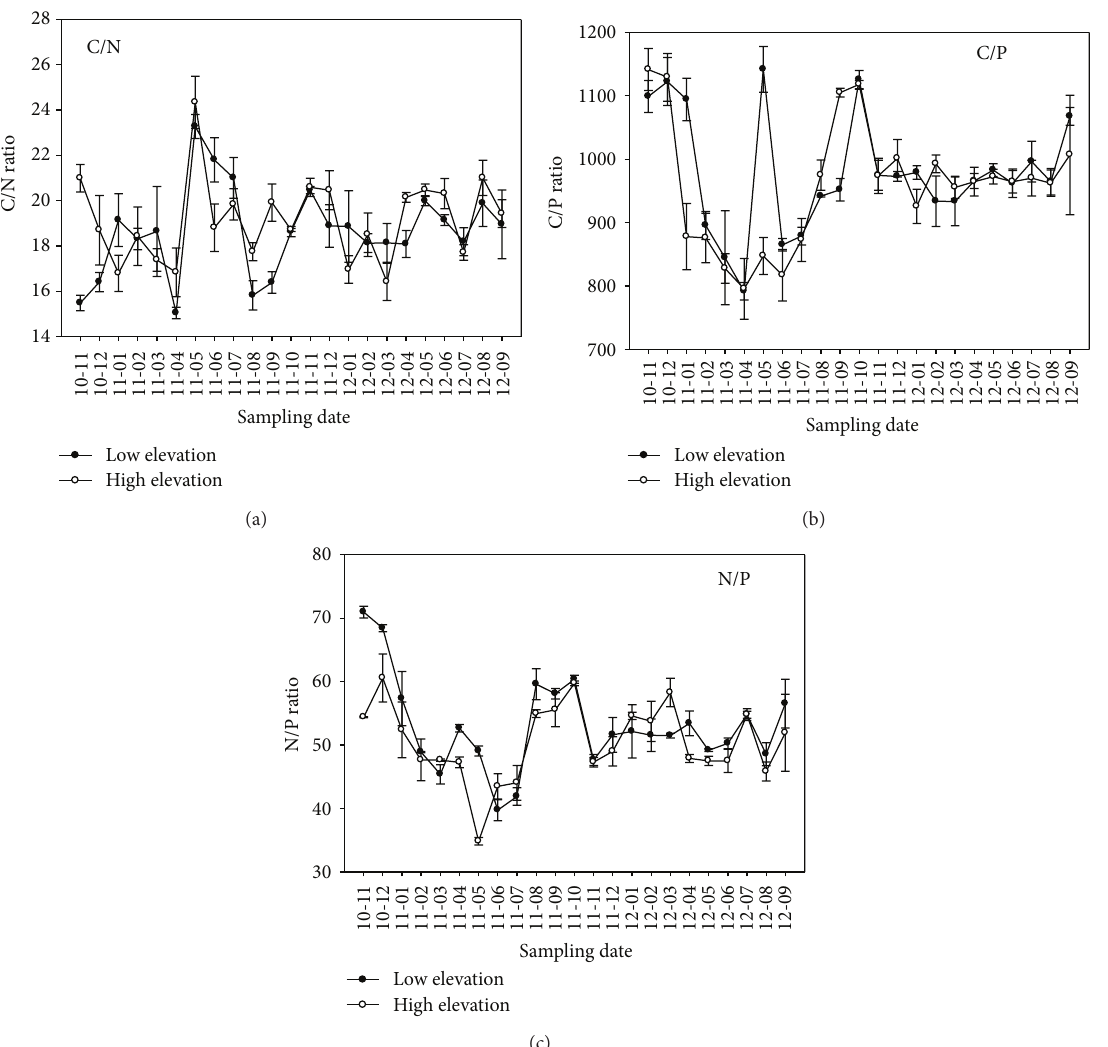
Figure 6: Dynamic variations of C/N ratio, C/P ratio, and N/P ratio on leaf litter at two